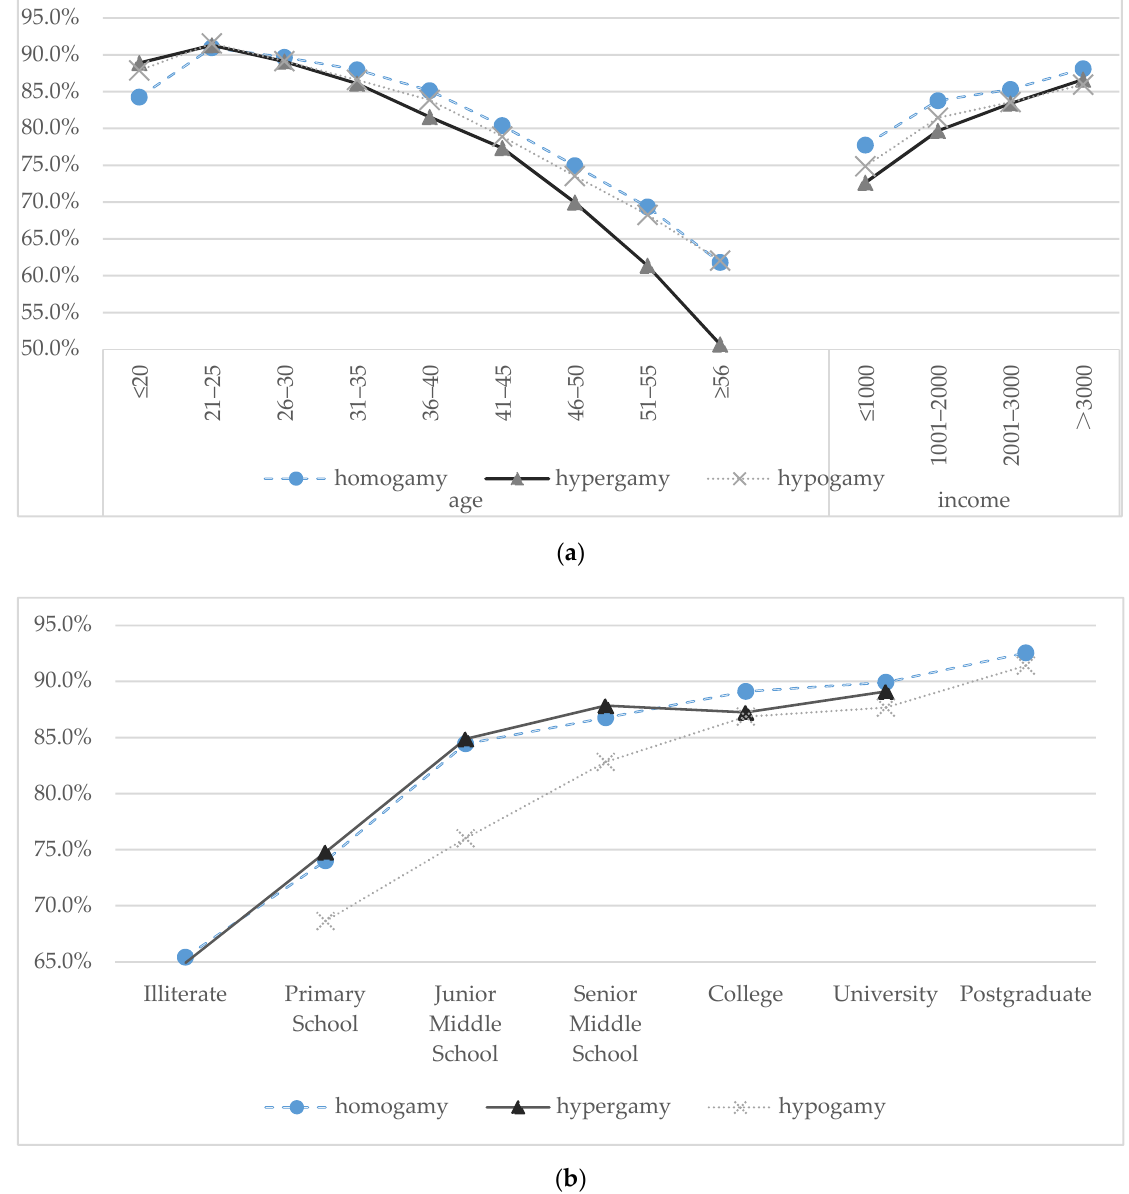
Figure 3. ( a ). SRH of different internal migrants (Age ‐ specific and income ‐ specific outcomes) (N = 127,829); ( b ). SRH of different internal migrants (Education ‐ specific outcomes) (N = 127,829).